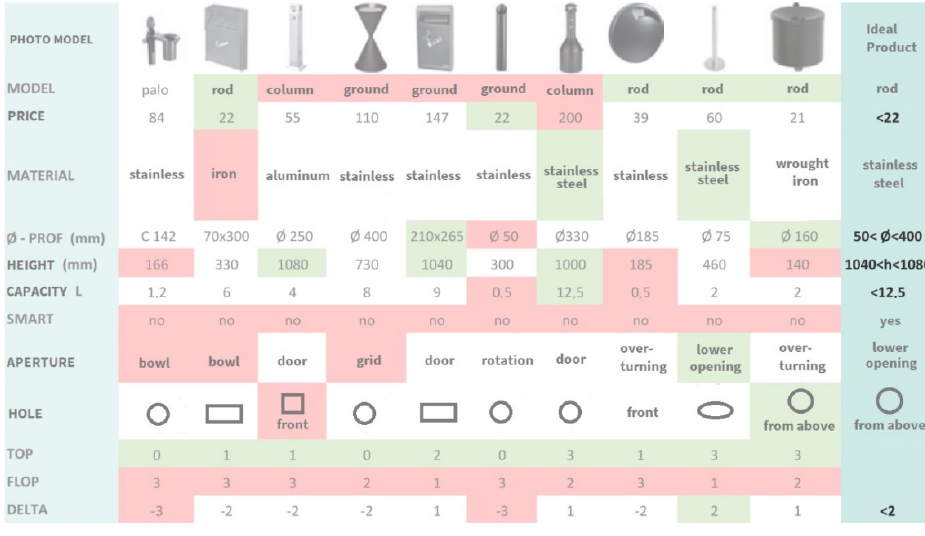
Figure 6. Benchmarking—Top-Flop analysis.